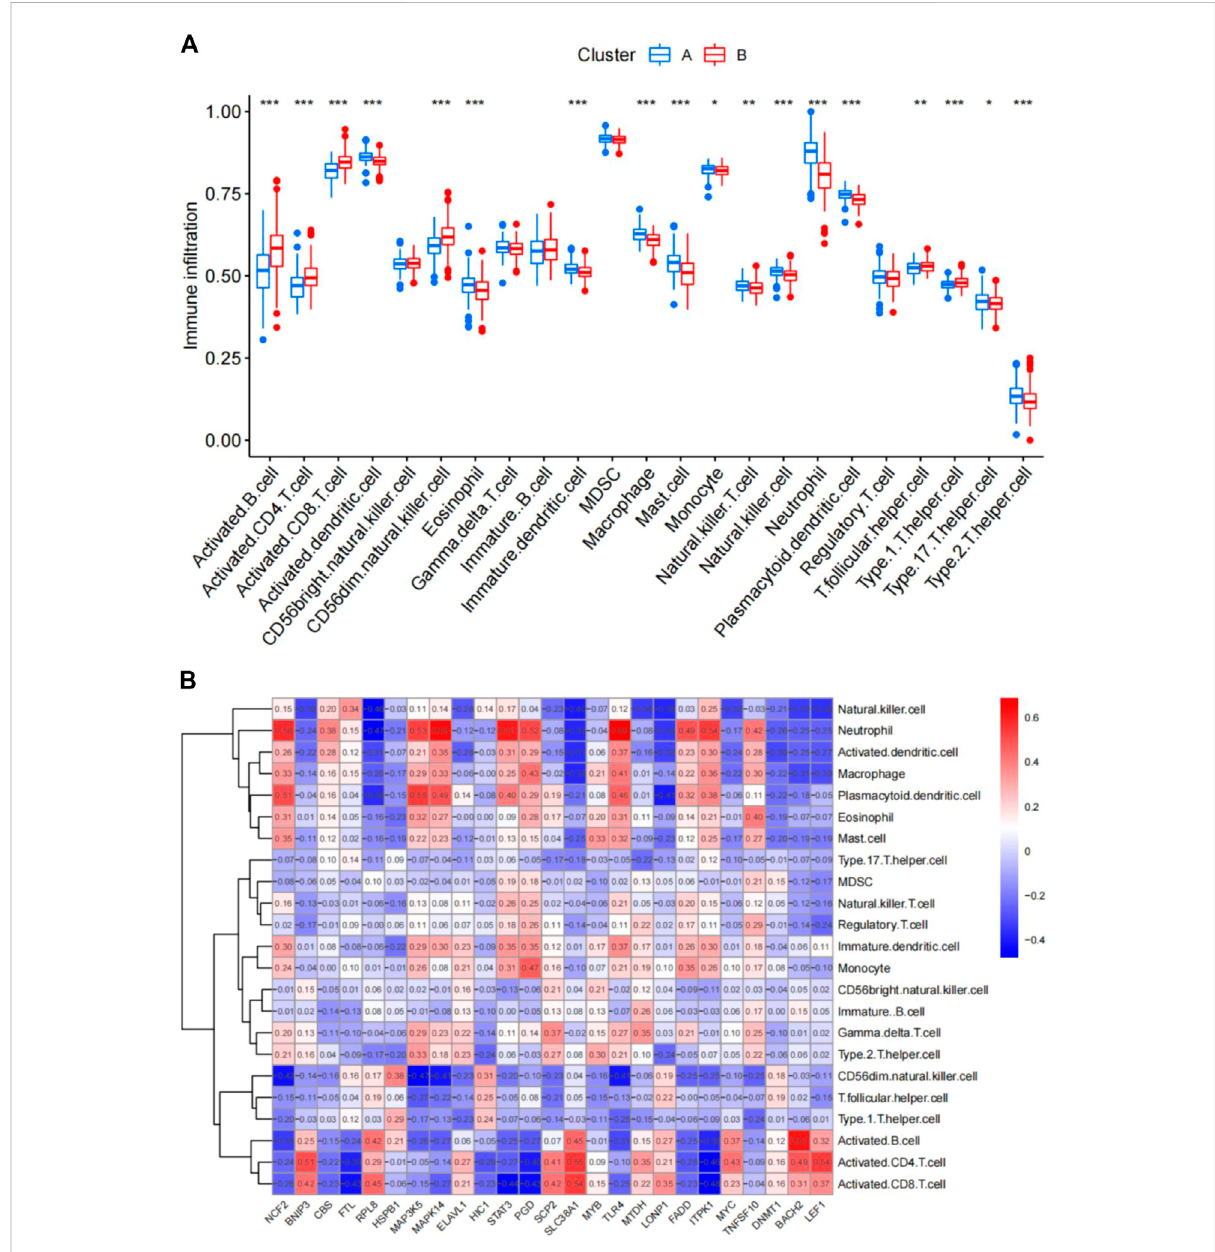
FIGURE 7 Single-sample gene set enrichment analysis. (A) Differential immune cell in fi ltration between cluster A and cluster B. (B) Correlation between in fi ltrating immune cells and the 25 ferroptosis- and necroptosis-related genes. * p < 0.05, ** p < 0.01, and *** p < 0.001.